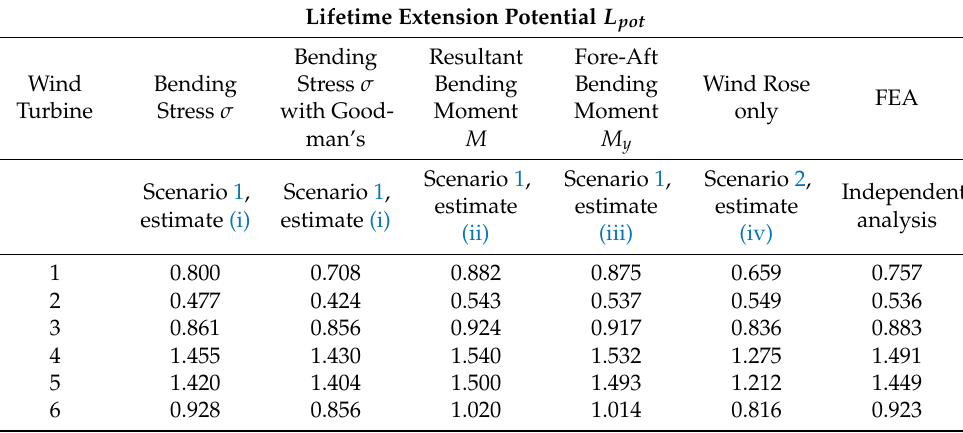
Table 1. Farm-wide overview of lifetime potential for case study wind turbines 1 to 6 relative to turbine